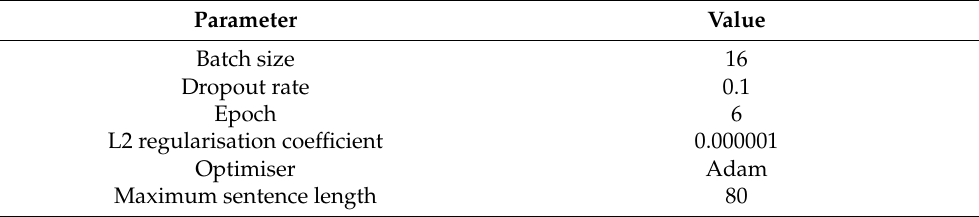
Table 2. Training